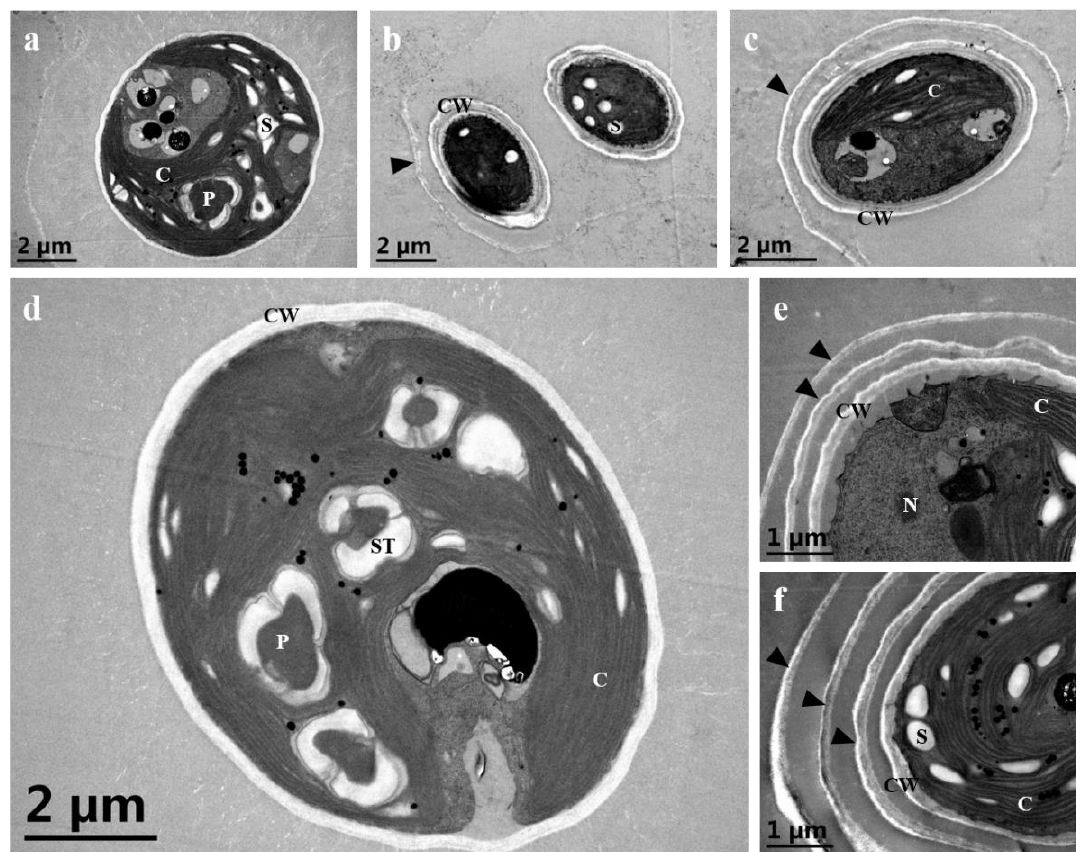
Figure 2. Transmission electron microscopy of Euchlorocystis marina sp. nov. ( a and d ) Mature cells; ( b and c ) Young cells; ( e and f ) Ultrastructure of multilayer mother cell wall. (CW = cell wall; C = chloroplast; P = pyrenoid; S = starch grains; ST = starch sheath; N = nucleus). The mother cell walls are indicated by black arrow.